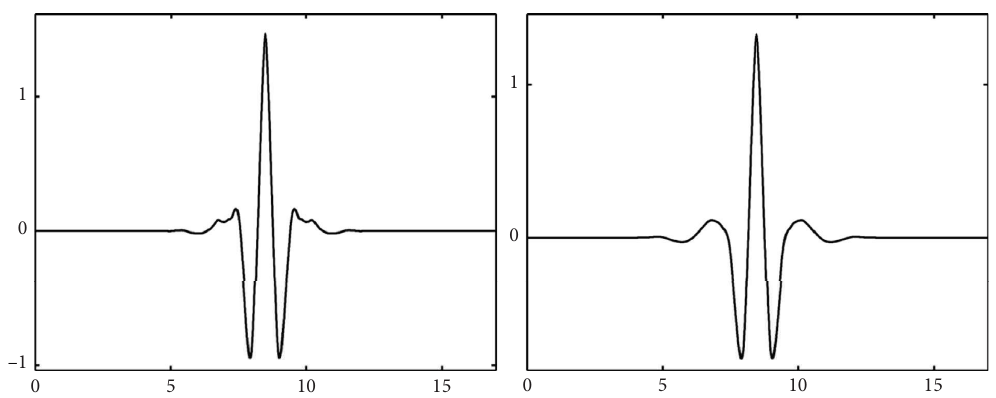
Figure 1: Mother wavelet function Bior6.8 for decomposition (a) and for reconstruction (b) [27].